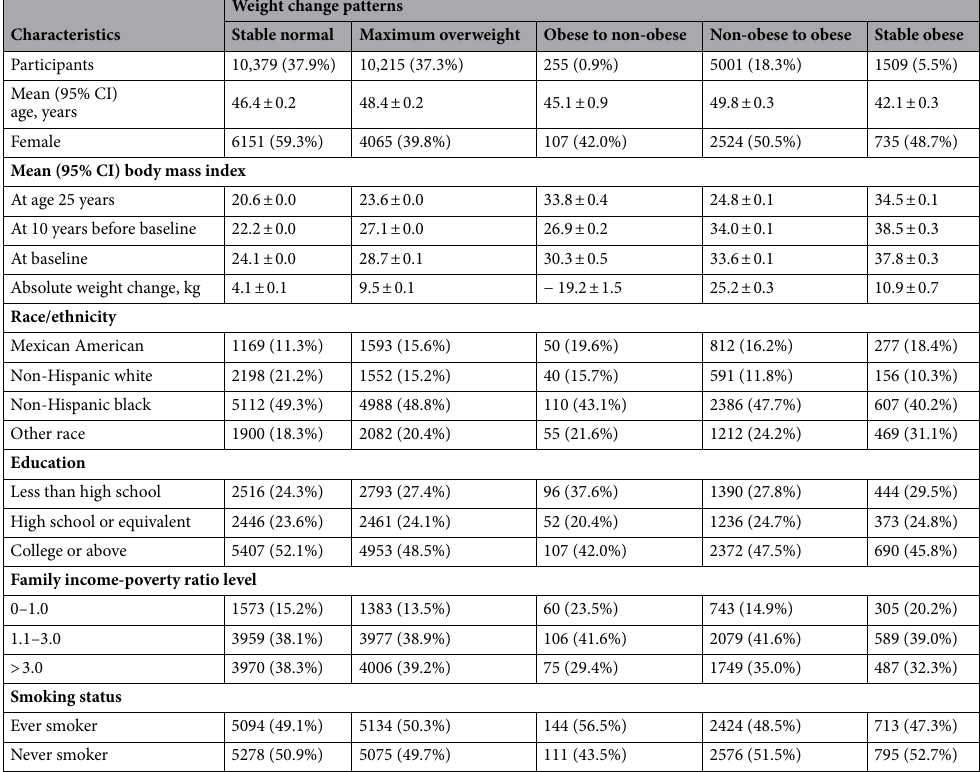
Table 1. Baseline characteristics of study participants in the NHANES 2001–2018 according to weight change patterns during adulthood. All estimates accounted for complex survey designs and the analyses used the sample weights, stratification and clustering suggested by the CDC. Twenty-three, 2298, and 15 participants had missing information for baseline education level, family income-poverty ratio, and smoking status